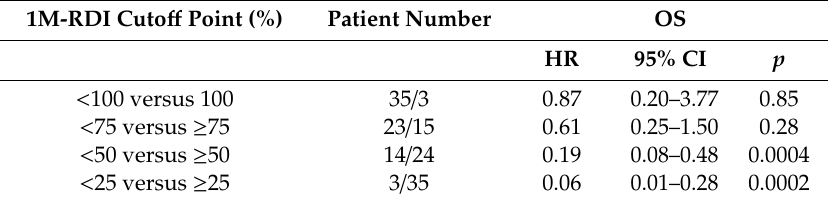
Table 2. Comparison of treatment results according to 1M-RDI cuto ff value.